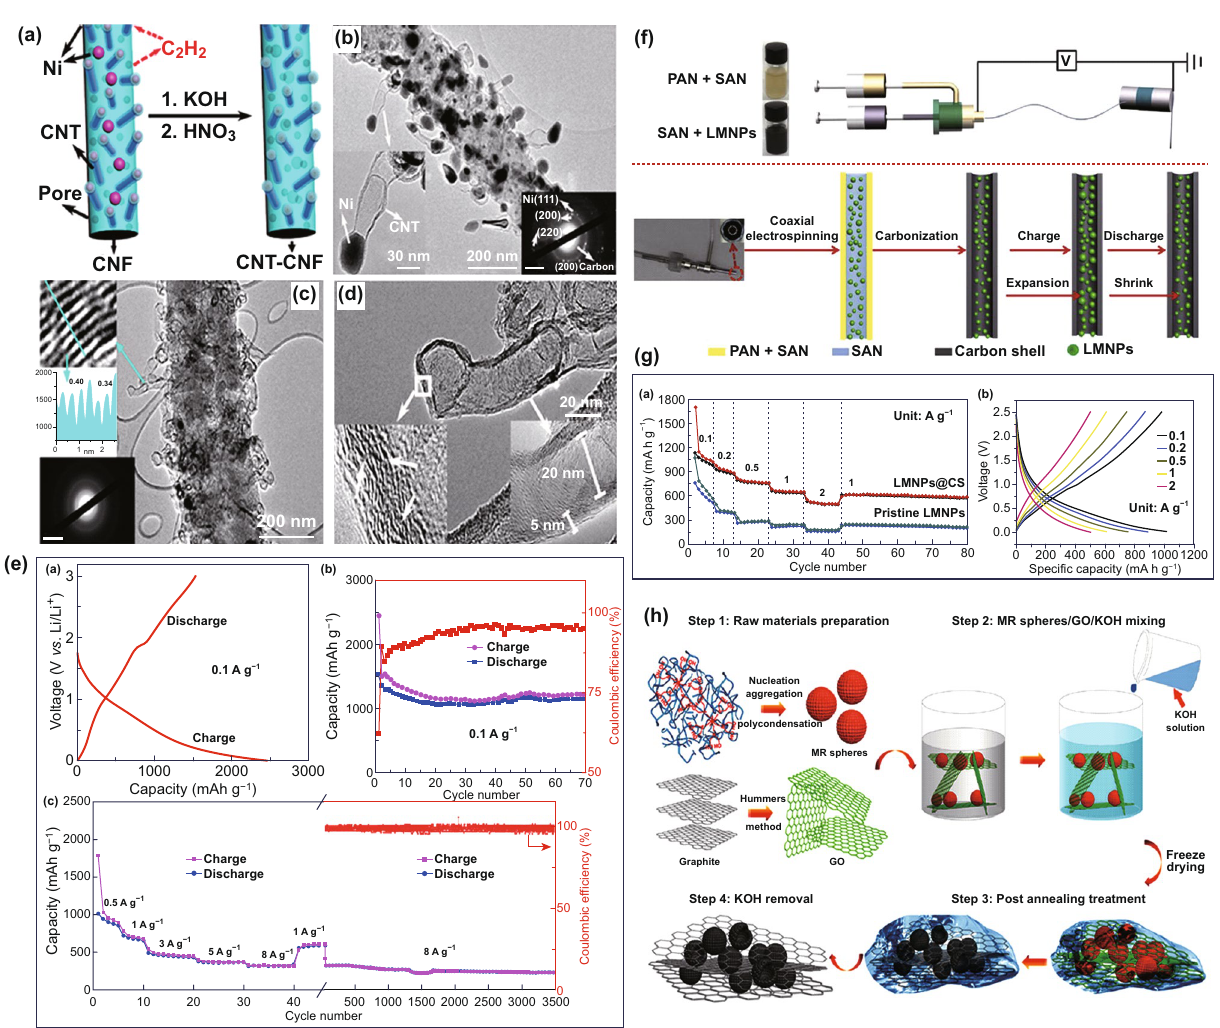
Fig. 8 a Synthesis schematic, and c SAED pattern and TEM image of the activated N-doped hollow CNT–CNF hybrid material. b SAED pat- tern and TEM image of the N-doped CNT–CNF–Ni hybrid material. d TEM and HRTEM images of CNT. e Electrochemical performance of activated N-doped hollow CNT–CNF hybrid electrode for LIBs. Reproduced with permission from Ref. [127]. Copyright 2013, American Chemical Society. f Schematic illustration of the electrospinning steps, and g electrochemical performance of the LMNPs@CS electrode. Repro- duced with permission from Ref. [135]. Copyright 2019, Elsevier. h Synthesis schematic of the DHCSs/RGO composite materials. Reproduced with permission from Ref. [136]. Copyright 2018, American Chemical